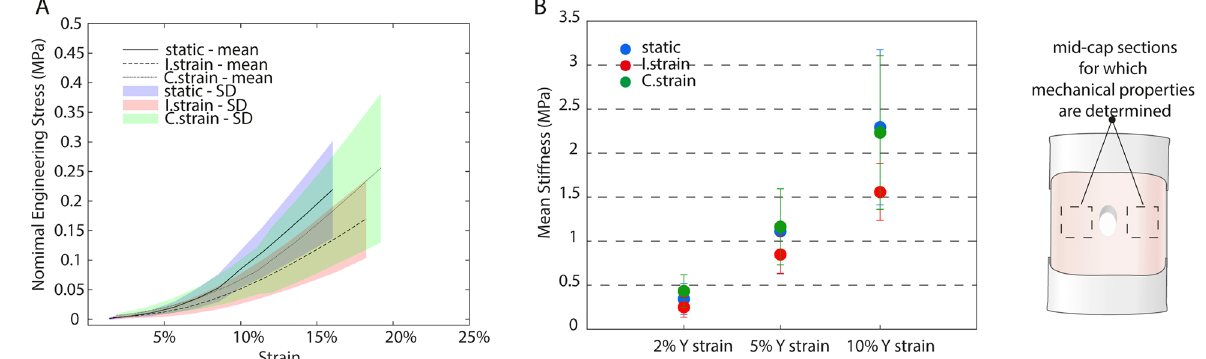
Figure 6. Mechanical characterization of the tissues after 21 days of (dynamic) cell culture. Illustrative nominal engineering stress–strain curves for each experimental group investigated ( A ). Average calculated stiffness values for the mid cap sections at 2%, 5% and 10% ɛ yy per experimental group (n ≥ 5 per group) ( B